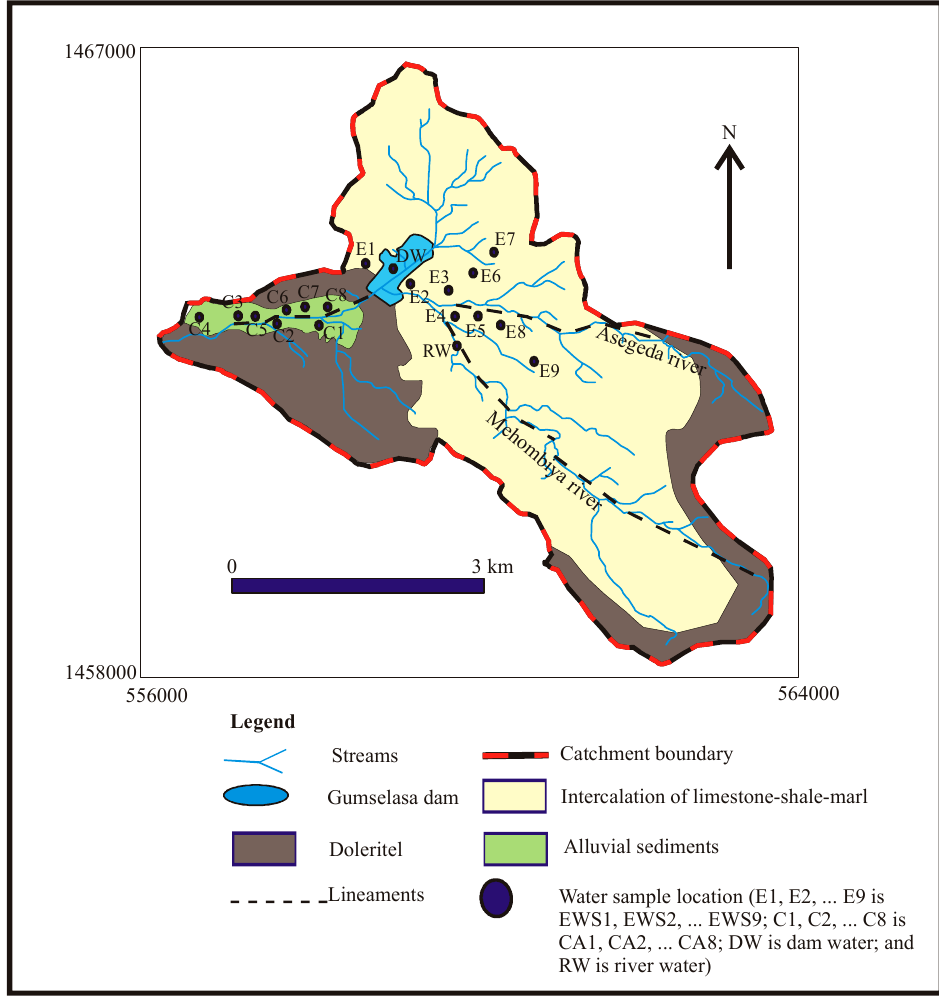
Figure 2. Geological map of the catchment.